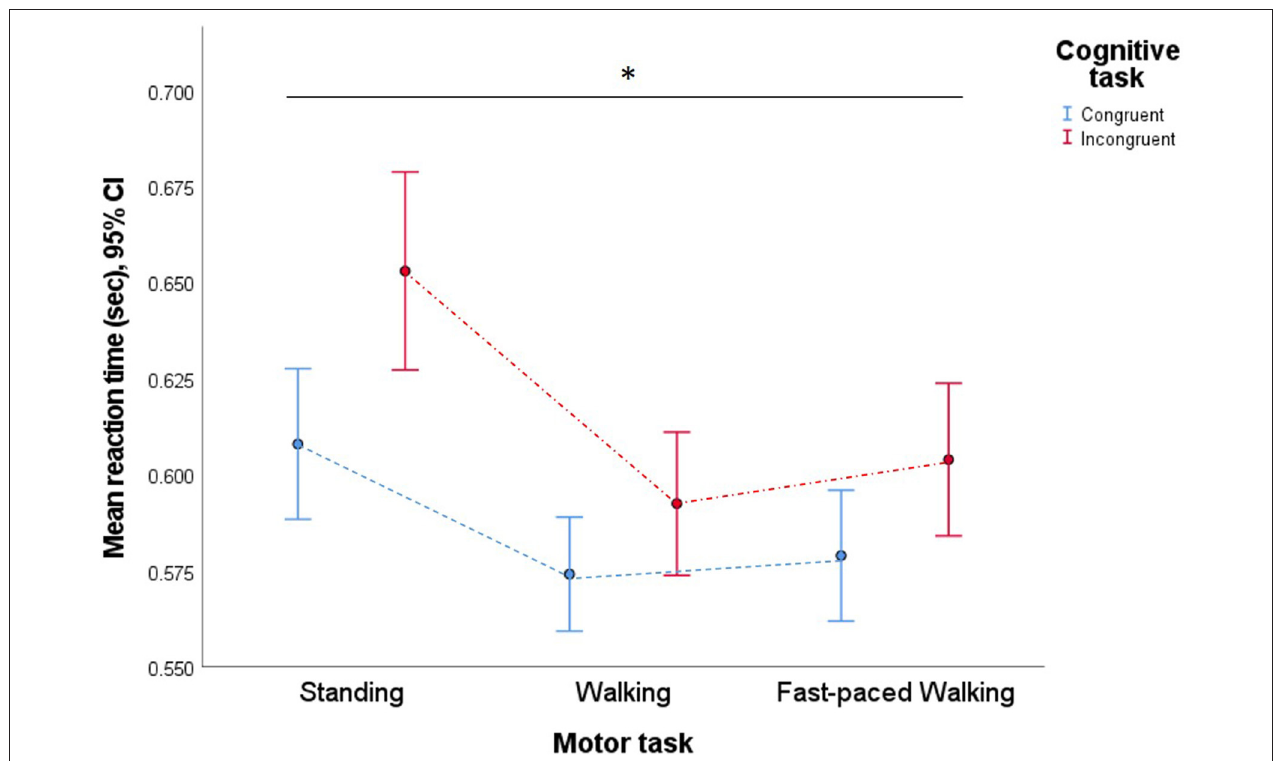
FIGURE 4 | Means reaction time for the congruent and the incongruent task in all VR dual-tasking conditions. Figure showing two-way interaction between motor task and cognitive task on reaction time (* p < 0.05).